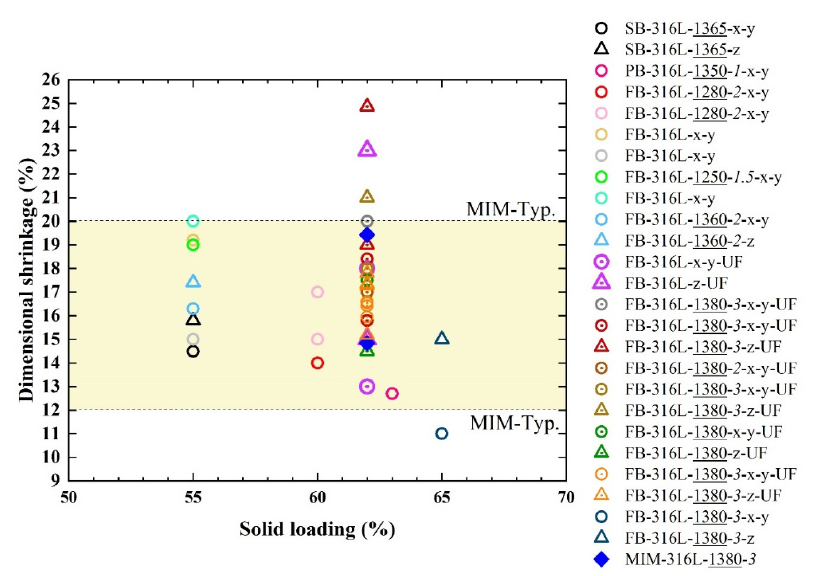
Figure 16. Solid loading vs. dimensional shrinkage map of 316L stainless steel fabricated by the metal MEX process with different conditions comparing with typical MIM. The underlined number represents sintering temperature ( ° C) and the italic number represents sintering time (h); x-y (aver- age from length and width) or z (thickness) indicate the direction of shrinkage measurement. Data from